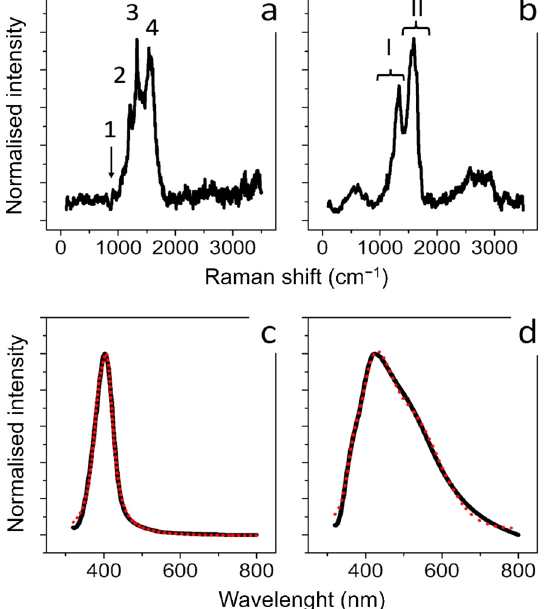
Figure 2. Raman ( a ) and UV-V is absorbance spectra ( c ) obtained from conventional Ag NPs syn- thesized using citrate: 1, 2, 3, and 4 in ( a ) marked the peaks related to n(C–COO), n s(COO), n s(COO) and n as(COO) of citrate; Raman ( b ) and UV-VIS absorbance spectra ( d ) obtained from green Ag NPs. (I), (II) in ( b ) marked the peaks related to C=C and C=O bonds. In ( c , d ), the black lines represented the experimental optical absorption and the dashed red curve the experimental fit.